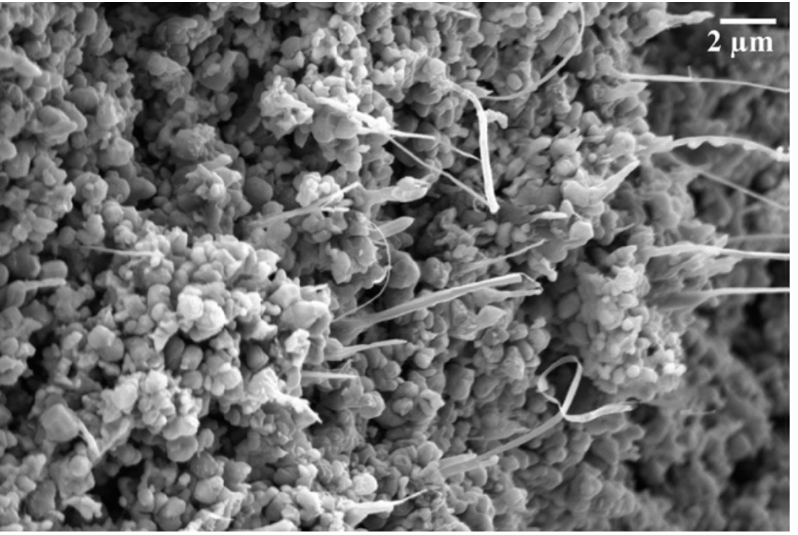
Figure 6. Carbon deposition in the anode. Reprinted with permission from Ref. [22].